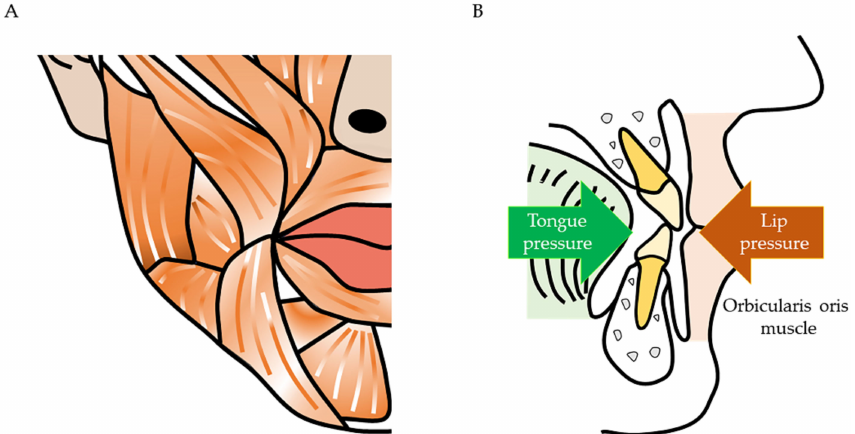
Figure 1. Relationship between dentition and facial muscles. ( A ) The muscles run vertically and hori- zontally on the face. ( B ) The teeth move to the position where the pressure is balanced. The dentition receives muscle pressure medially from the tongue muscles and laterally from the orbicularis oris and buccinator muscles. Orthodontists perform myofunctional therapy because abnormal oral habits (e.g., infant-type swallowing and tongue thrusting habit) adversely affect the